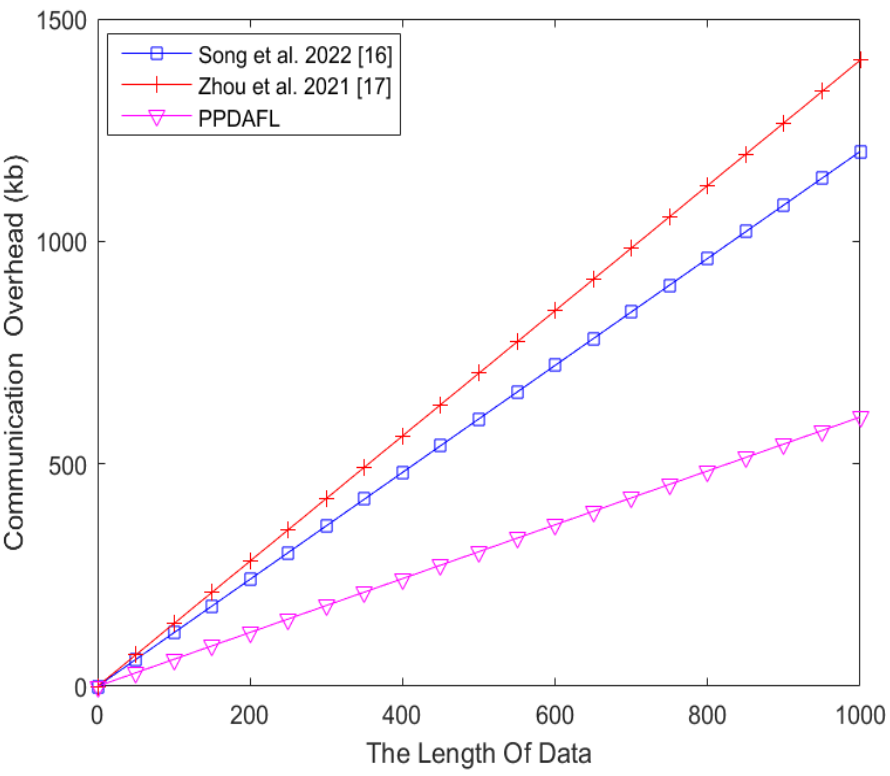
Figure 6. Comparison of communication overhead when 𝐾 = 200 [16,17].